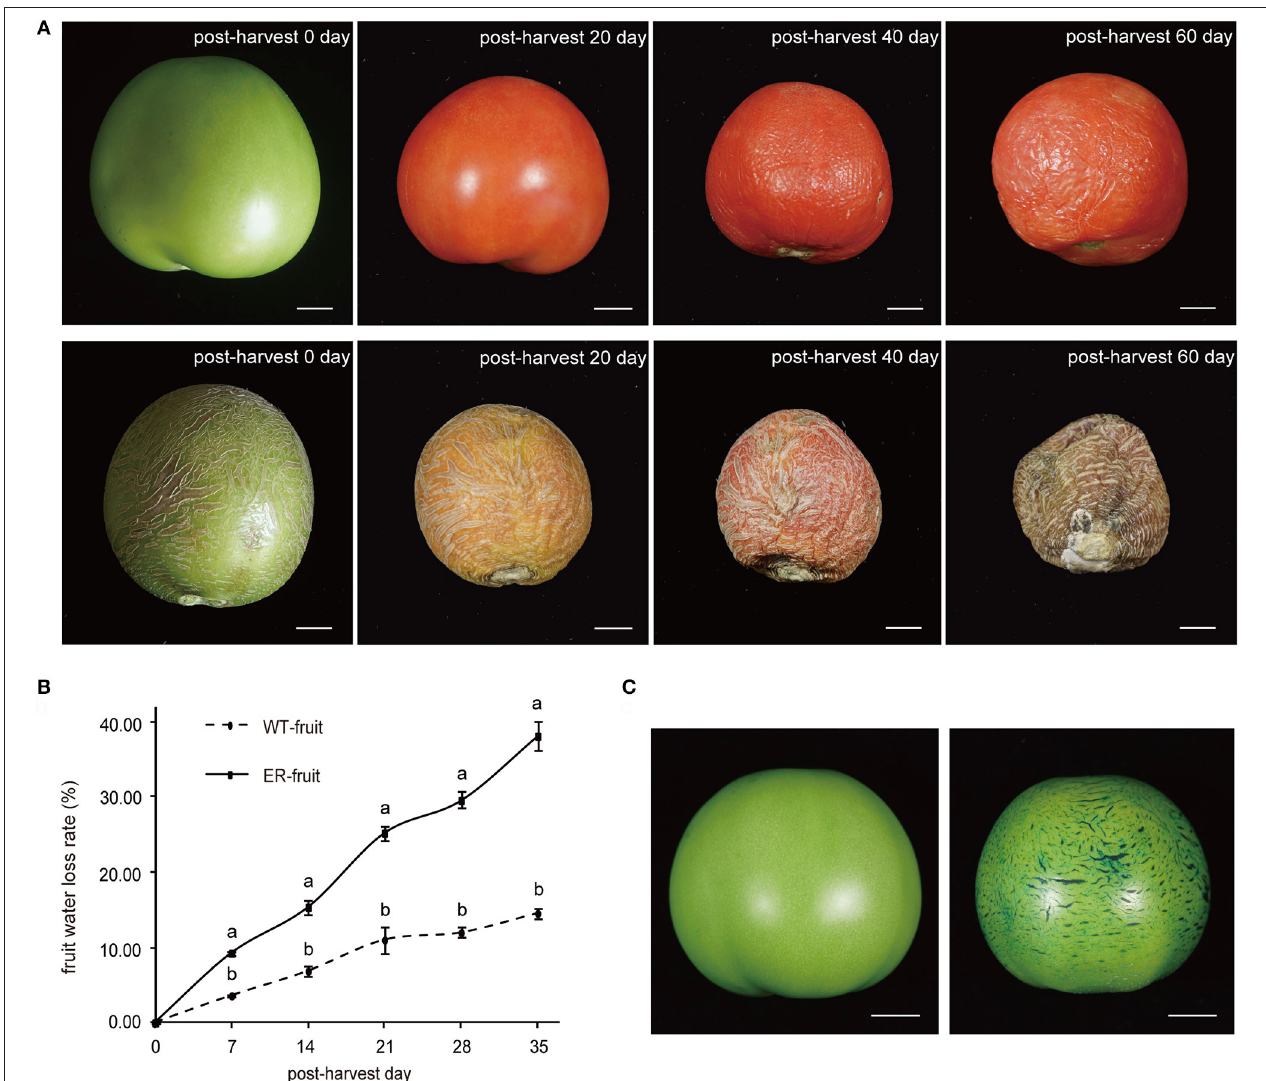
FIGURE 2 | Analysis of transpirational water loss from mature wild type (WT) and epidermal reticulation (ER) fruit. (A) Comparison of the phenotypes of normal and ER fruits during postharvest storage. The upper row of fruit are WT and the lower row are ER. (B) Postharvest fruit water loss from WT and ER fruits over a 5-week period. The data are presented as the mean ± SD , and the different letters in the same days indicated significant difference between two samples at 0.05 level (C) Toluidine blue (TB, 0.5% solution) staining of WT (left) and ER (right) fruit 40 days after pollination (DAP). Scale bar = 1 cm.